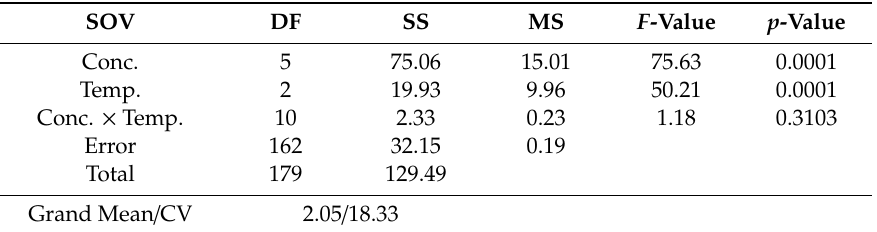
Table A9. Nymphal development time of 4th instar ( M. persicae ) in relation to PeBL1 elicitor and temperature. SOV DF SS Conc. Temp. Conc. ×